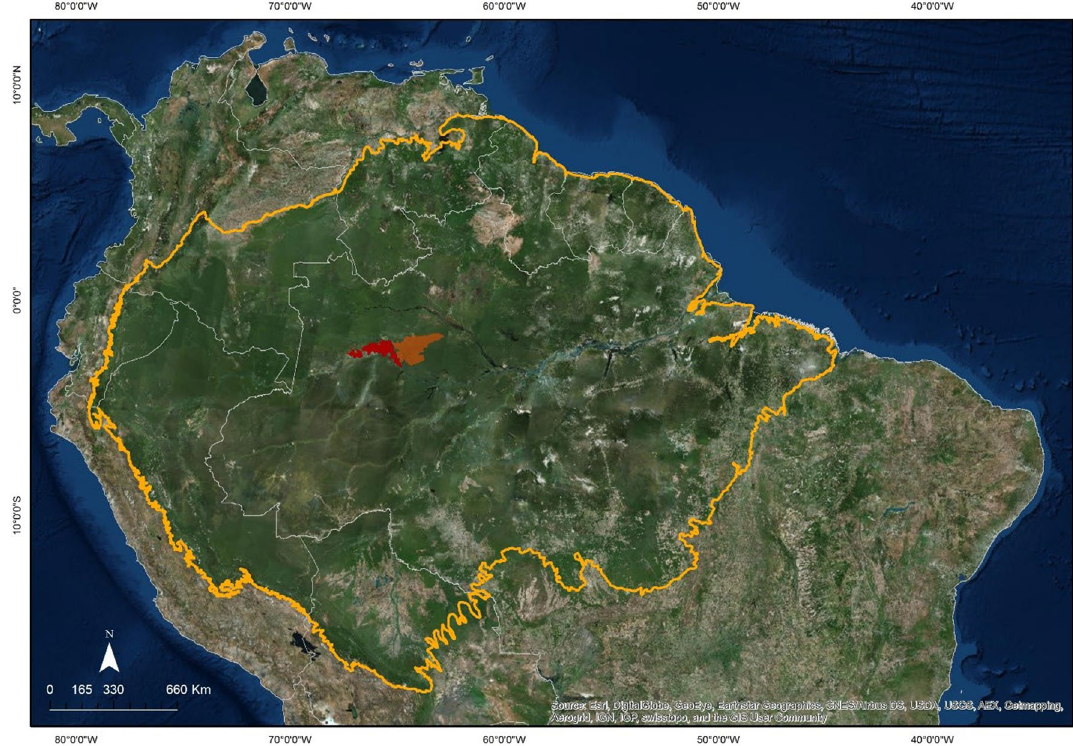
Fig.2 Location of Sustainable Development Reserves Mamirauá (in red) and Amanã (in orange), in the Central Amazon,